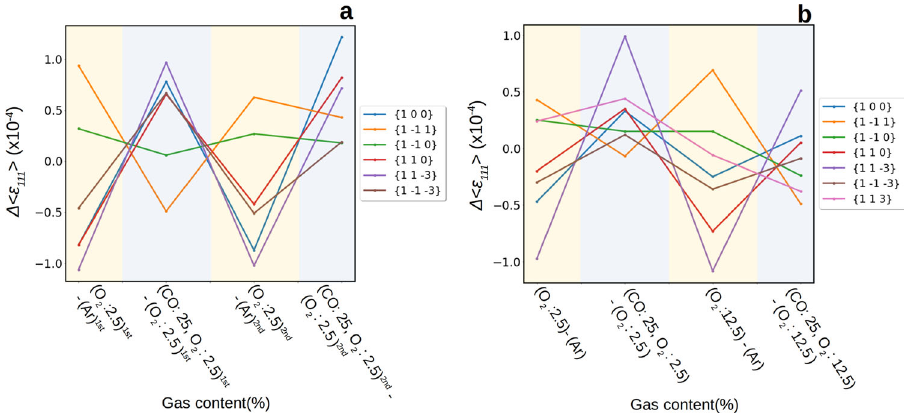
Fig. 6 Comparison of the average strain evolution ( Δ ϵ 111 ) per { hkl } facet subfamily during O 2 adsorption and CO oxidation. The strain variation is given between two consecutive gas conditions. a NP300, fi rst two cycles ( χ = 10). b NP650 ( χ = 10) and ( χ = 2). A yellow background indicates a switch from pure Ar to Ar + O 2 while a blue background indicates a switch from Ar + O 2 to CO oxidation reaction conditions. (cid:1) for the {1 11}-type facets or a relaxation of the surface tensile (cid:1) (cid:1) (cid:1) strain for the {100}, {11 3}, {1 1 3} and {110} facets (see also Sup-